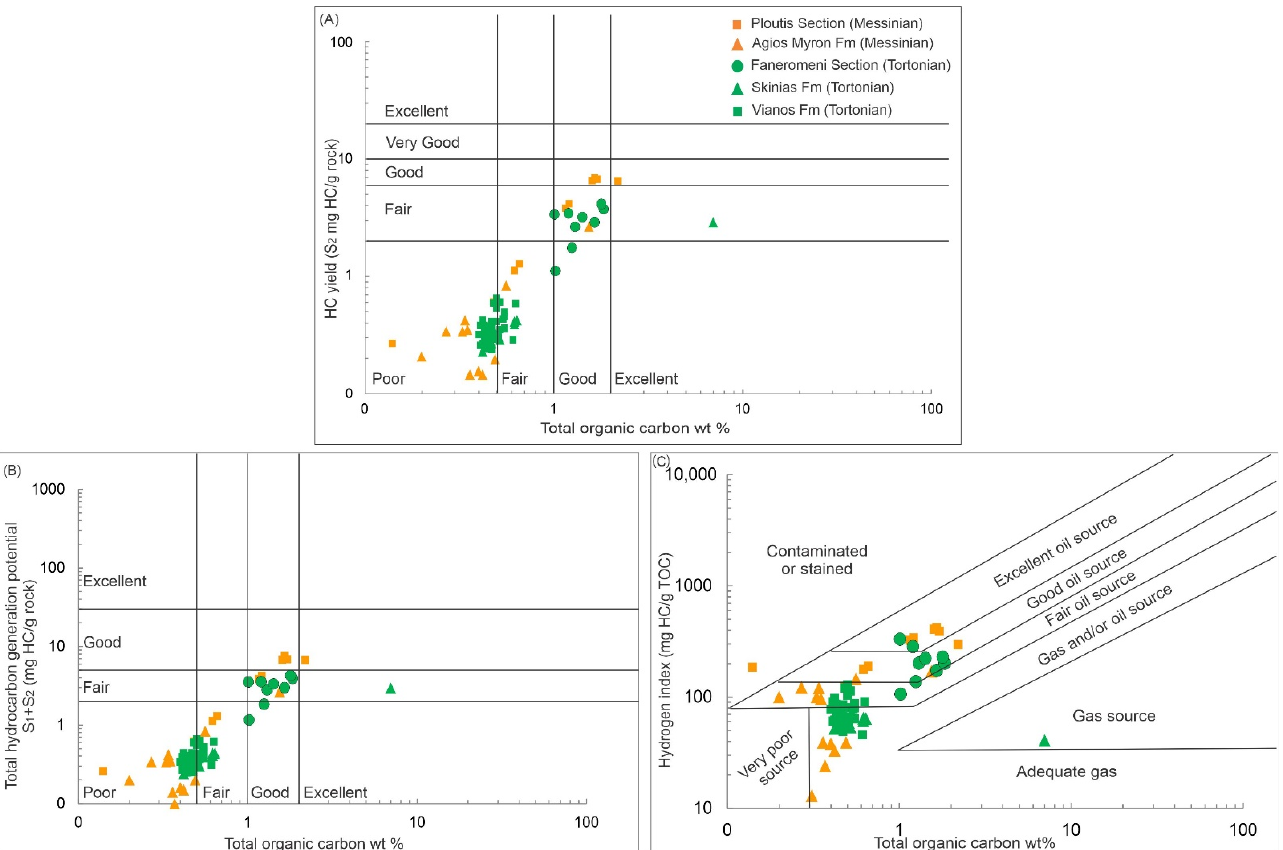
Figure 4. Evaluation of hydrocarbon generative potential of the examined samples from Crete Island. ( A ) Cross-plot of S2 vs. total organic carbon, ( B ) Classification diagram of total hydrocarbon generating potential vs. total organic carbon and, ( C ) Cross-plot of hydrogen index vs. total organic carbon. These diagrams suggest that the most promising samples come from Moulia Fm (at Faneromeni) and Ploutis section, whereas Viannos, Skinias Fm and Agios Myron Fm exhibit little hydrocarbon generative potential. Green color refers to samples that are Tortonian in age, whereas orange color refers to samples that are Messinian in age.